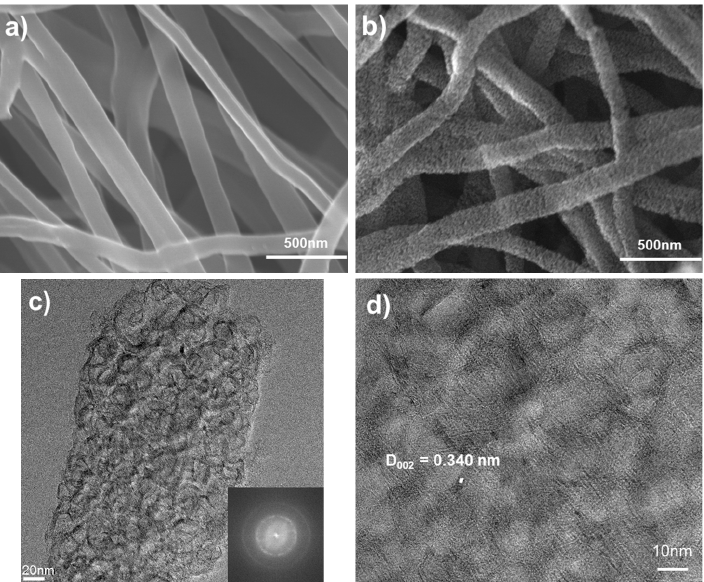
Figure 1. Scanning electron micrographs show ( a ) microporous carbon nanofibers carbonized at 700 °C and ( b ) highly mesoporous carbon nanofibers carbonized at 1400 °C; ( c ) transmission electron microscopy (TEM) and ( d ) high-resolution TEM (HR-TEM) images show the typical turbostratic structure created by carbonization at 1400 °C.